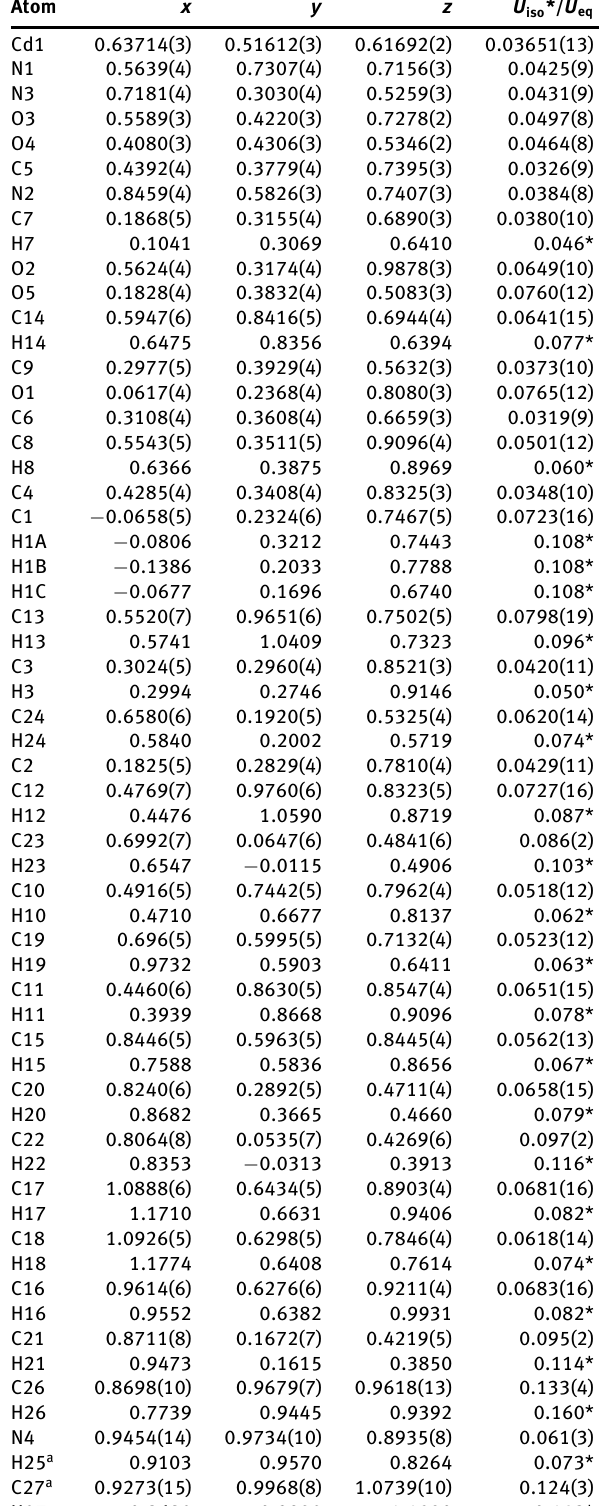
Table 2: Fractional atomic coordinates and isotropic or equivalent isotropic displacement parameters (Å 2